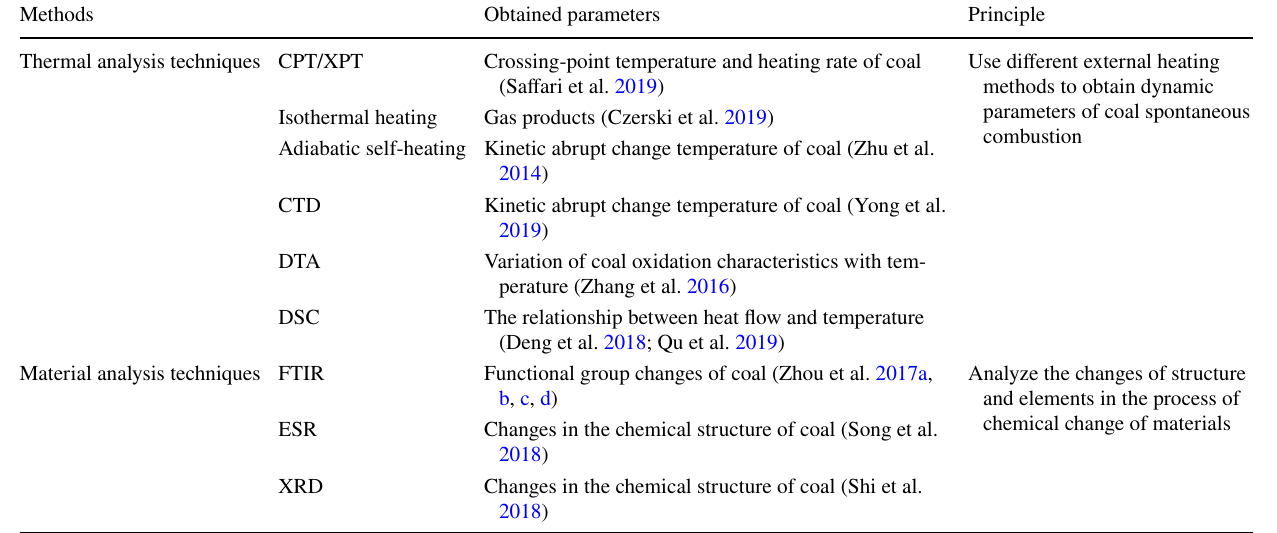
Table 1 Methods, obtained parameters and principles for studying on coal spontaneous combustion mechanism Methods Obtained